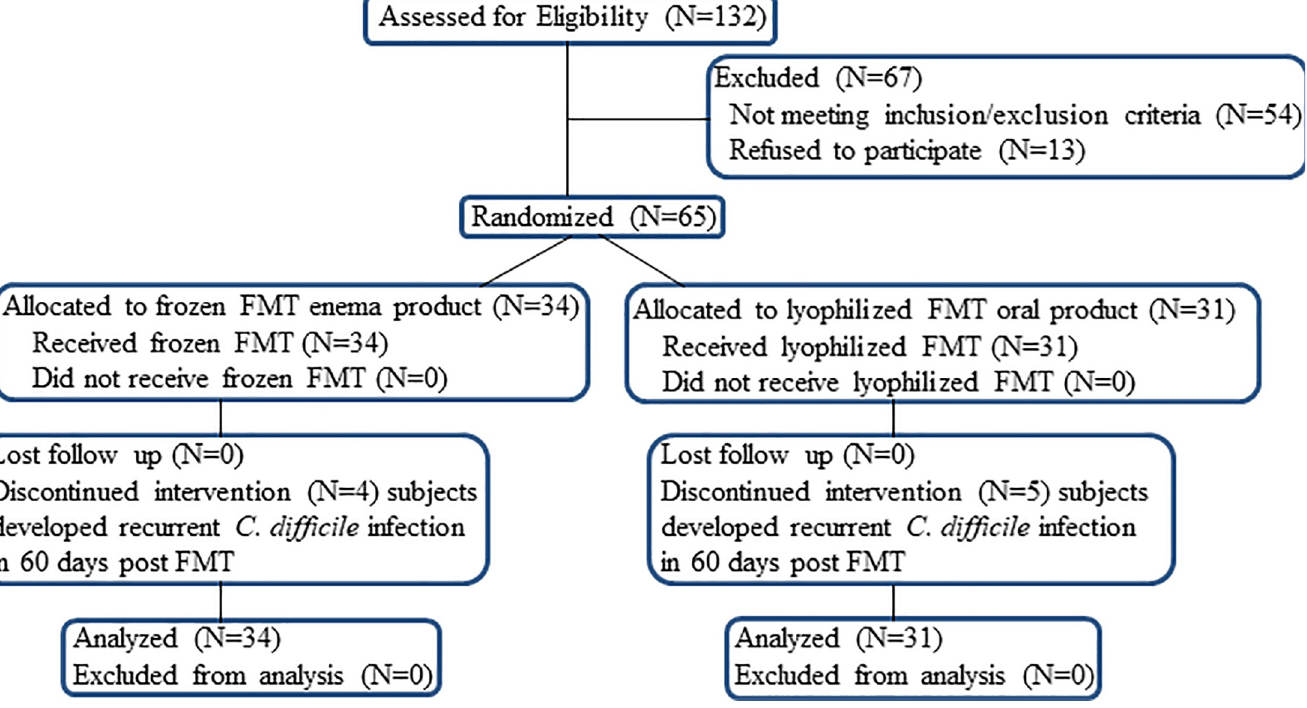
PLOS ONE | https://doi.org/10.1371/journal.pone.0205064 November2,